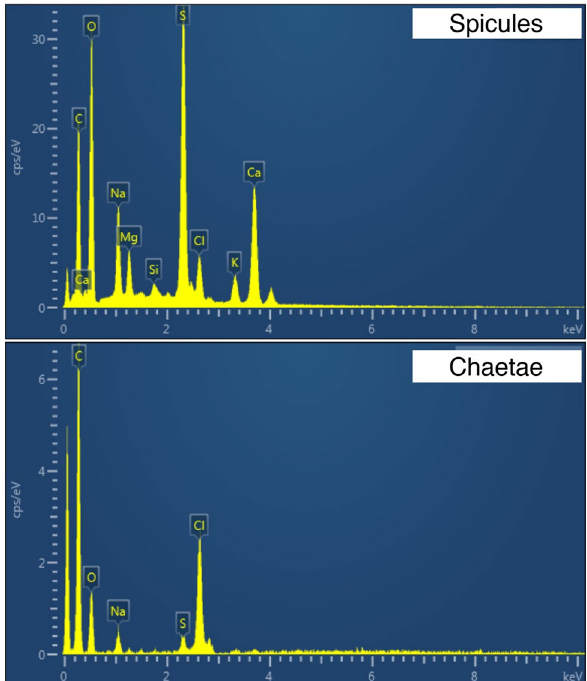
Figure 2. Results of energy-dispersive spectroscopy carried out on two tissue types in Thoracophelia minuta sp. nov. The figure was created with AZtecOne and Adobe Illustrator v CS6.